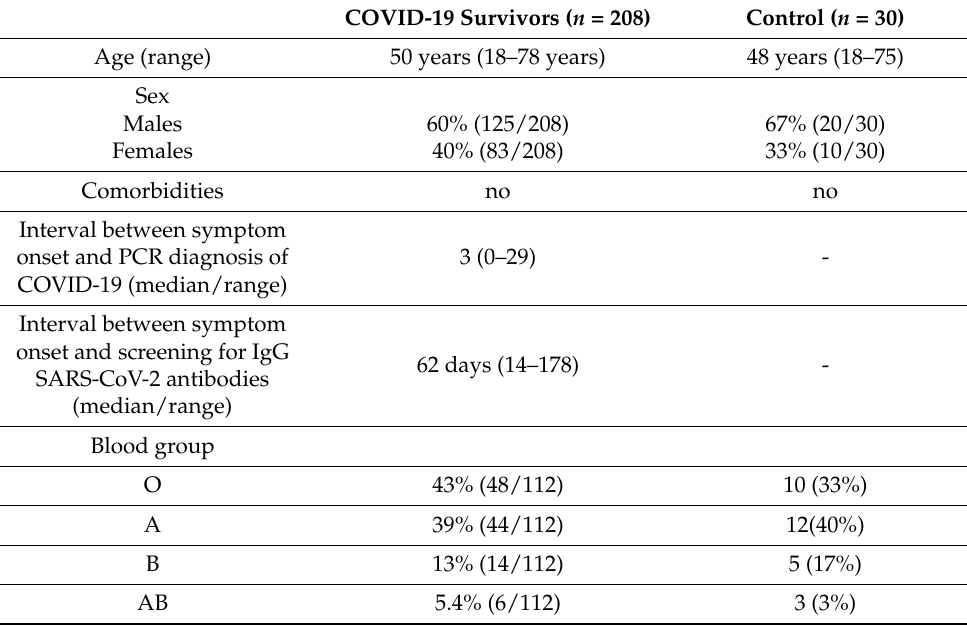
Table 1. Demographics and clinical data of COVID-19 survivors and